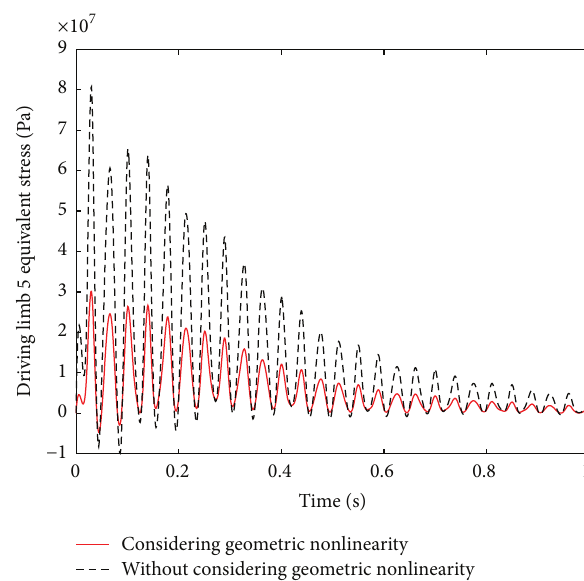
Figure 9: Equivalent stress of driving limb 3.